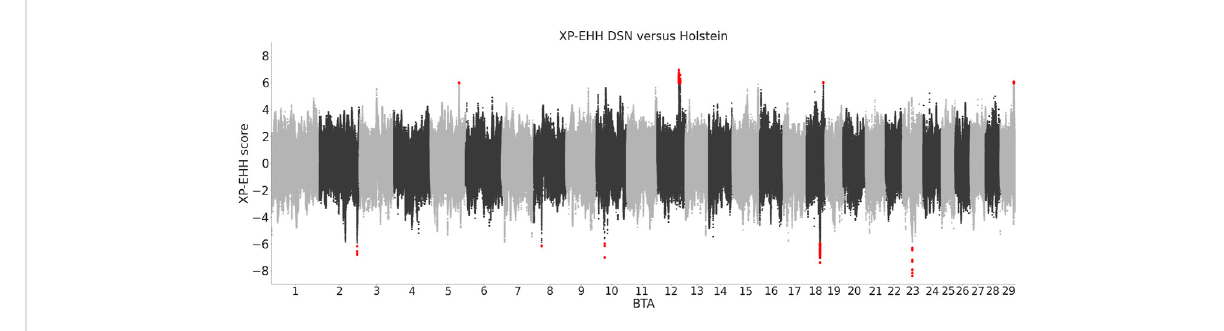
FIGURE 5 XP-EHH scores between DSN and Holstein. Positive scores represent variants positively selected in DSN in comparison to Holstein, and negative scores represent variants positively selected in Holstein in comparison to DSN. Signi fi cant scores are shown in